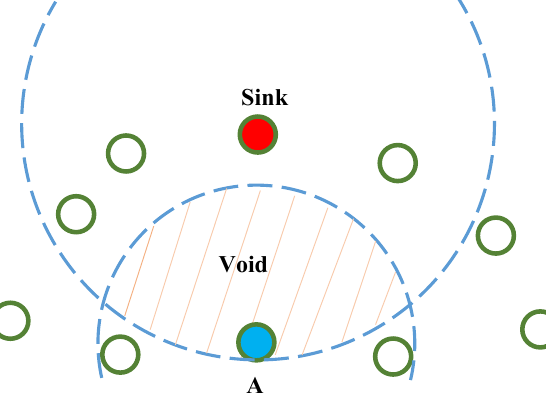
Figure 1. An example of local minimum